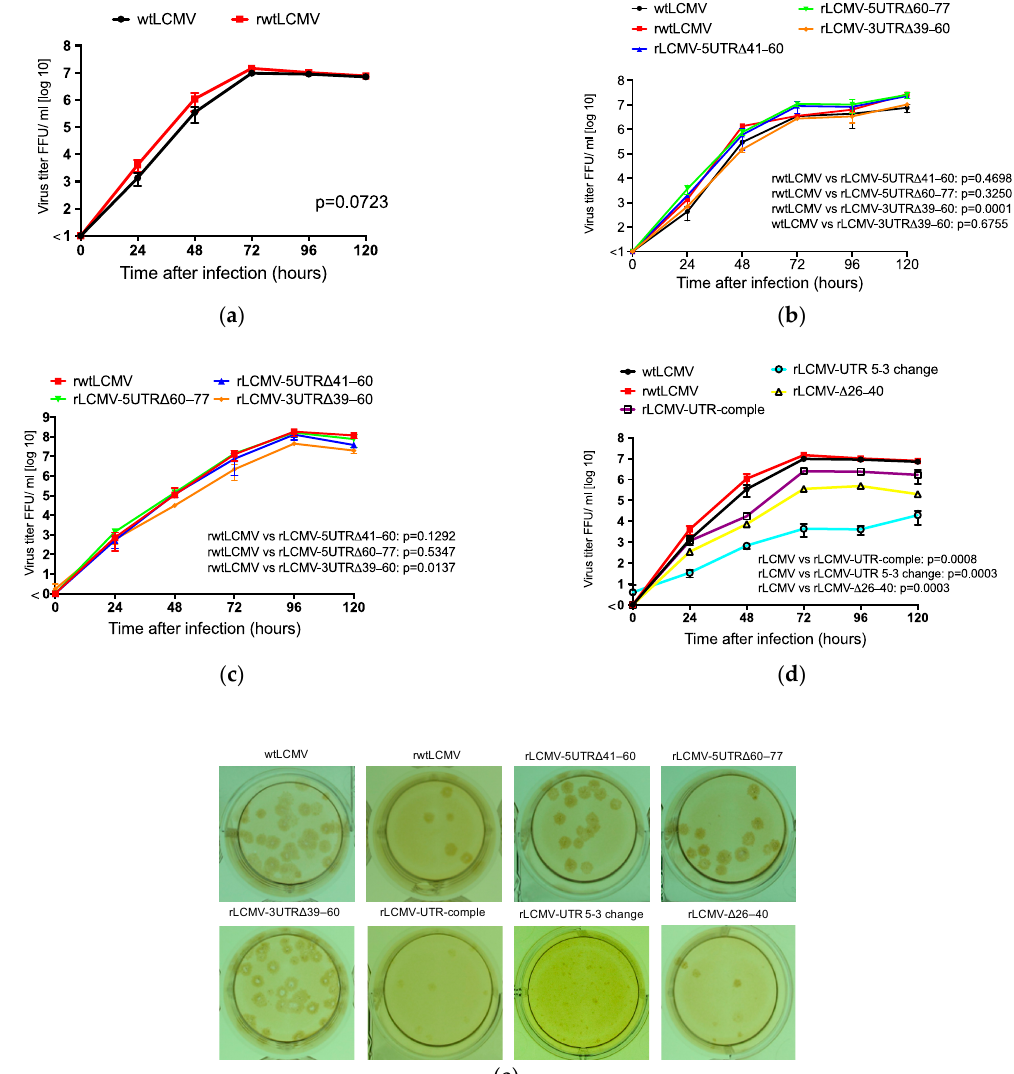
Figure 3. Viral growth properties in Vero and A549 cells: Confluent monolayers of Vero and A549 cells were infected with wtLCMV or rLCMVs at a multiplicity of infection (MOI) of 0.001 per cell. Cells were washed three times with medium after a one-hour adsorption period, and 1 mL medium was added to each well. Supernatant samples were collected at 0, 24, 48, 72, 96, and 120 h postinfection. The supernatants were centrifuged at 8000 × g for 5 min to remove cell debris and were stored at − 80 °C. The infectious dose was measured using a viral immunofocus assay. Viral growth curves of LCMVs were statistically analyzed using two-way ANOVA. ( a ) Viral growth properties of wildtype LCMV (wtLCMV) and recombinant non-mutated wildtype LCMV (rwtLCMV) in Vero cells were compared. ( b ) Viral growth kinetics of rLCMV-5UTR ∆ 41–60, rLCMV-5UTR ∆ 60–77, and rLCMV-3UTR ∆ 39–60 in Vero cells were compared with wtLCMV and rwtLCMV. ( c ) Viral growth kinetics of rLCMV-5UTR ∆ 41–60, rLCMV-5UTR ∆ 60–77, and rLCMV-3UTR ∆ 39–60 in A549 cells were compared with rwtLCMV. ( d ) Viral growth kinetics of rLCMV-UTR-comple, rLCMV-UTR 5-3 change, and rLCMV- ∆ 26–40 in Vero cells were compared with wtLCMV and rwtLCMV. ( e ) Focus morphology of wtLCMV and rLCMVs in Vero cells: The focus morphologies of wtLCMV and rLCMVs generated in this study are shown. Error bars indicate standard deviations. All experiments shown were conducted in triplicate.